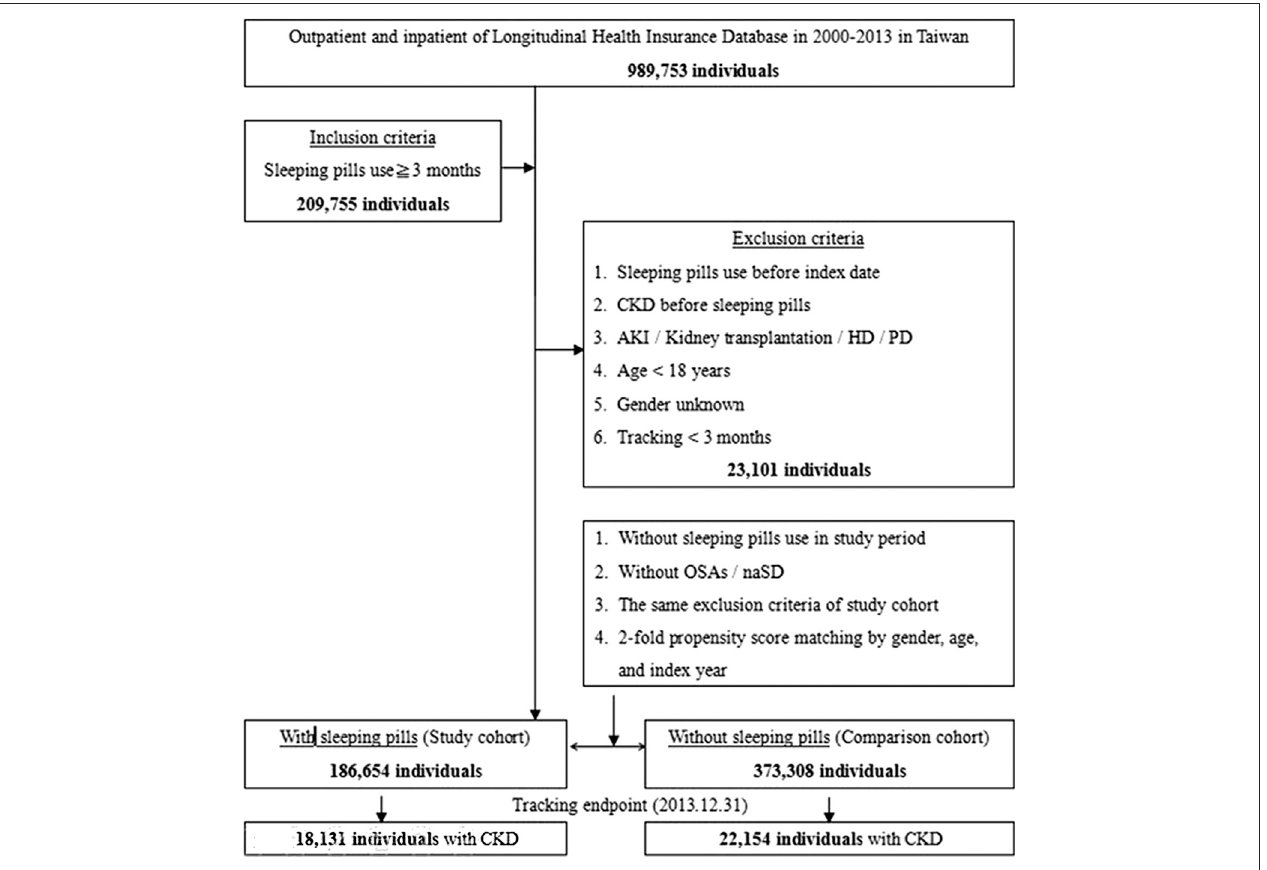
FIGURE 1 | The fl owchart of study sample selection from the National Health Insurance Research Database in Taiwan.